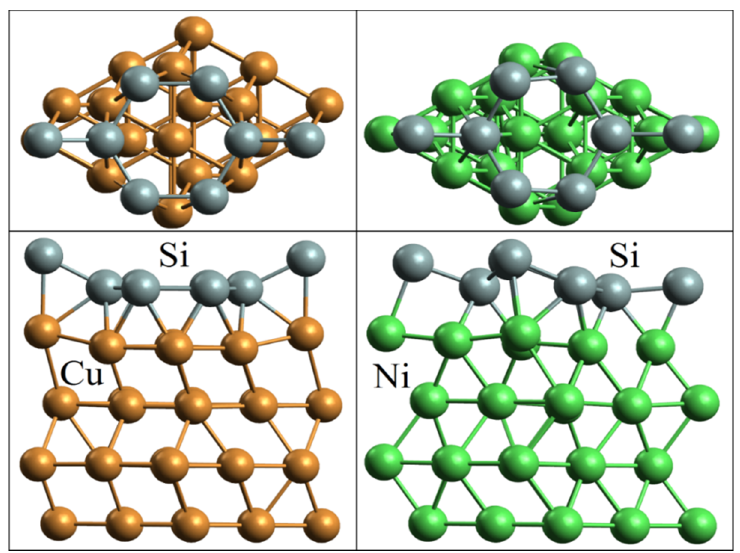
Figure 2. Geometrical structures of silicene on four-layer copper and nickel substrates after geomet- ric optimization.